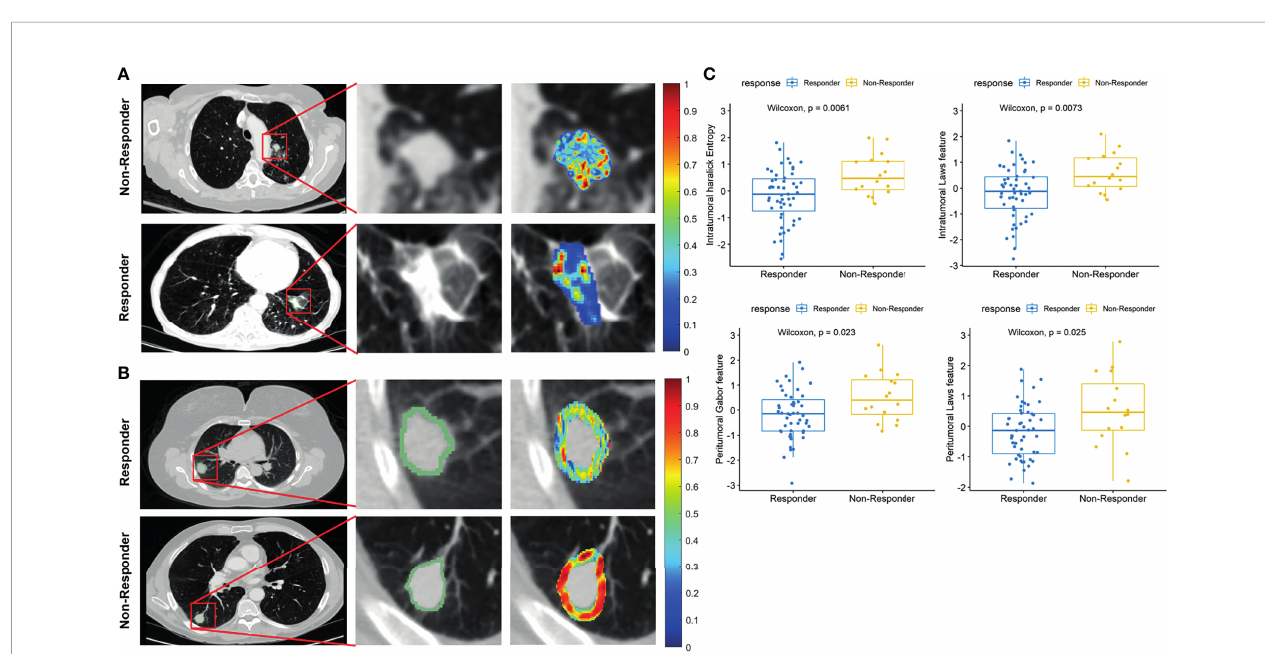
FIGURE 6 | (A) Segmented tumor regions and heatmap of intratumoral Haralick (entropy) feature in the pretreatment CT scans for representative non-responder and responder patients. (B) Segmented tumor regions and heatmap of peritumoral Gabor feature in the pretreatment CT scans for representative non-responder and responder patients. The middle column is a magni fi ed view of tumor anatomy in both Figures 5A, B , and the right column is a color heatmap. (C) Box-and- whisker plots for four features that best distinguish chemotherapy